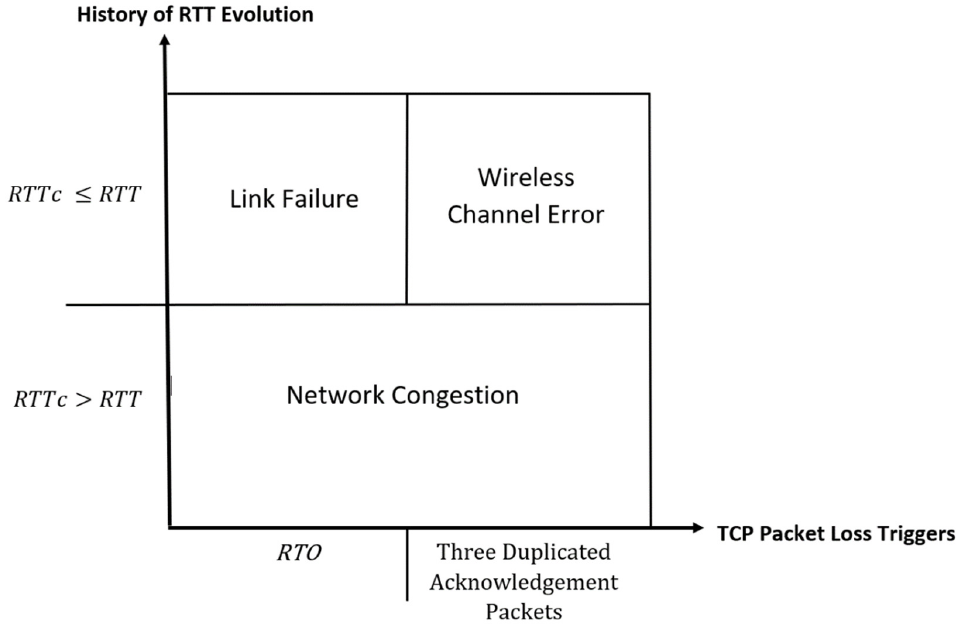
Figure 2. Illustrating the key concept of loss differentiation algorithm of TCP-LoRaD.